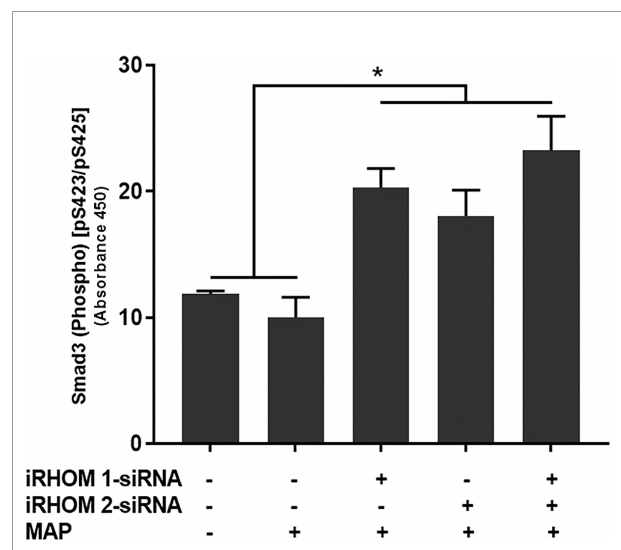
FIGURE 6 | The impact of TACE regression on the downstream phosphorylation of Smad3. The Kolmogorov – Smirnov normality test was used to test the normal distribution for all values and a two-way analysis of variance (ANOVA) was used to assess signi fi cance among experiments, which was followed by a Bonferroni correction test. All experiments were performed in triplicates. *Indicates P-value of less than